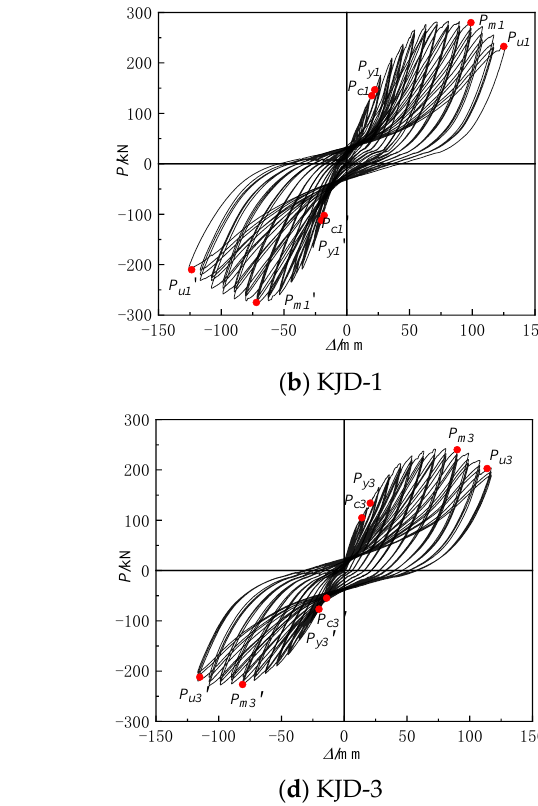
gentle and exhibits a good ductility. The bearing capacity of specimens decreases faster with the increasing pre-damage degree. The ranking of the bearing capacity of the rein- forcement specimens during forward loading is KJD-1 > KJD-2 > KJD-3, and significantly larger than KJD-0. than KJD-0.